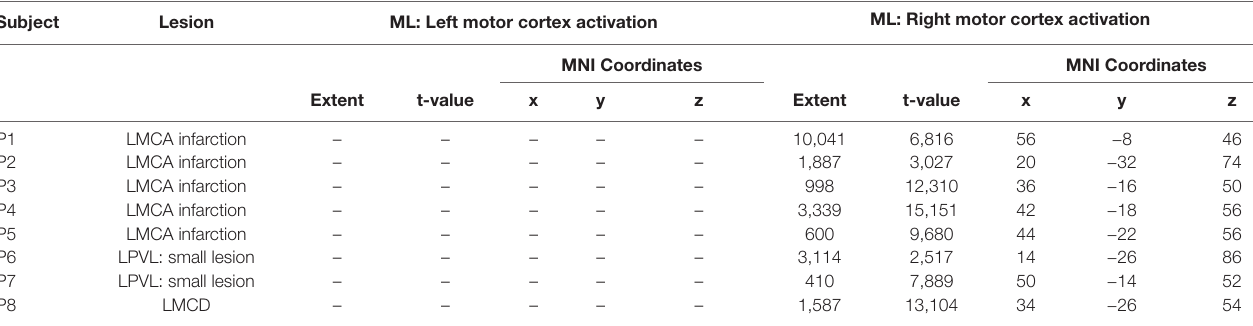
TABlE 2 | Activation in the PMC during finger tapping with the nonimpaired